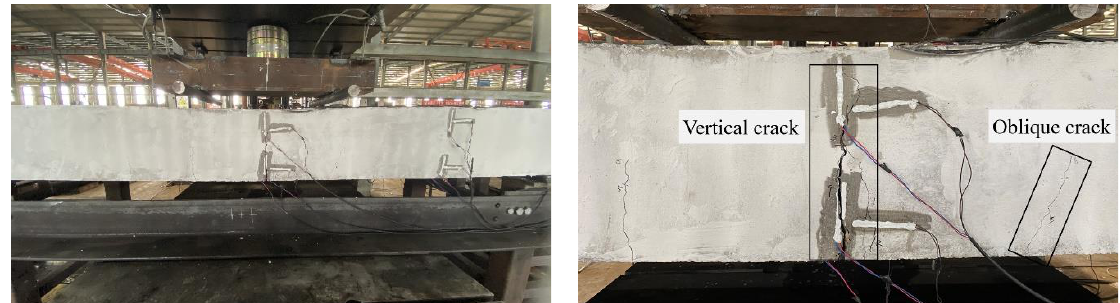
Figure 7. Failure characteristics of the BEJC50 × 6 component.